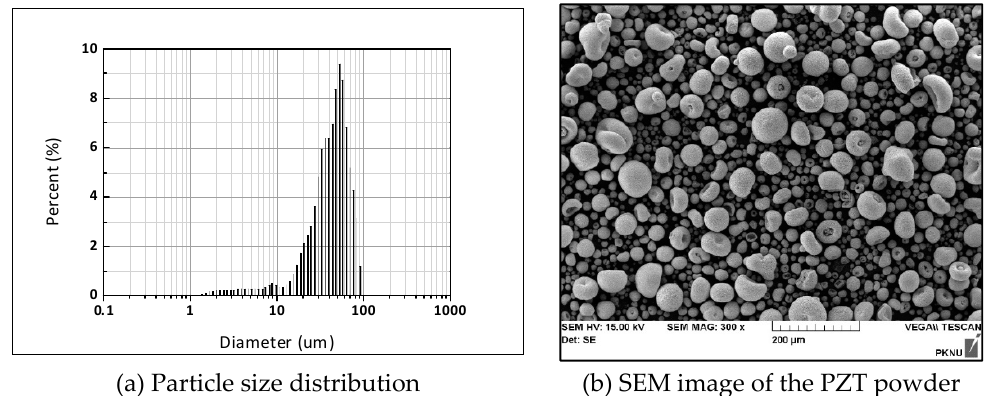
Figure 1. Characteristics of the commercial lead zirconate titanate (PZT) powder: ( a ) Particle size distribution ( b ) scanning electron microscopy (SEM) image of the S-51 PZT powder.